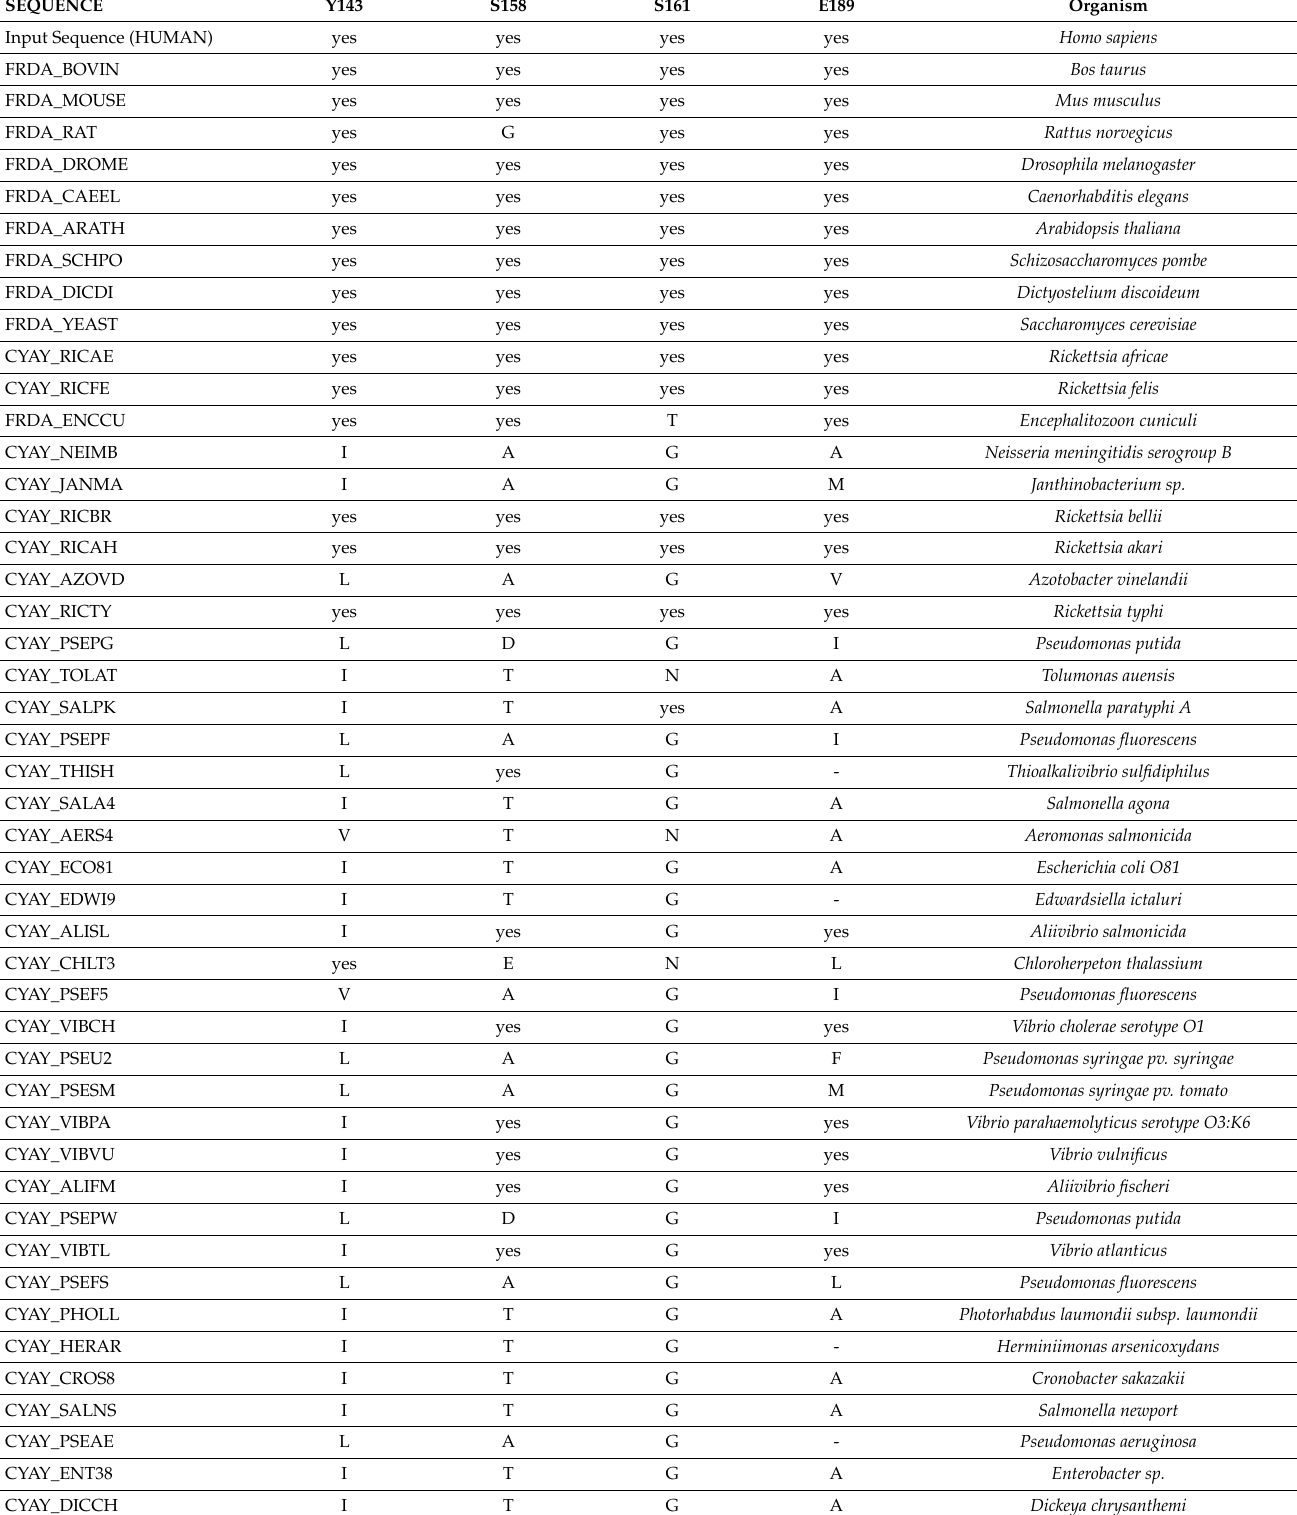
Table 1. Presence of the four amino acids from conservation cluster 3 in the 47 sequences analyzed. Presence of the indicated residue in the sequence is indicated by “yes”. The one-letter code is used when other residues are found in that